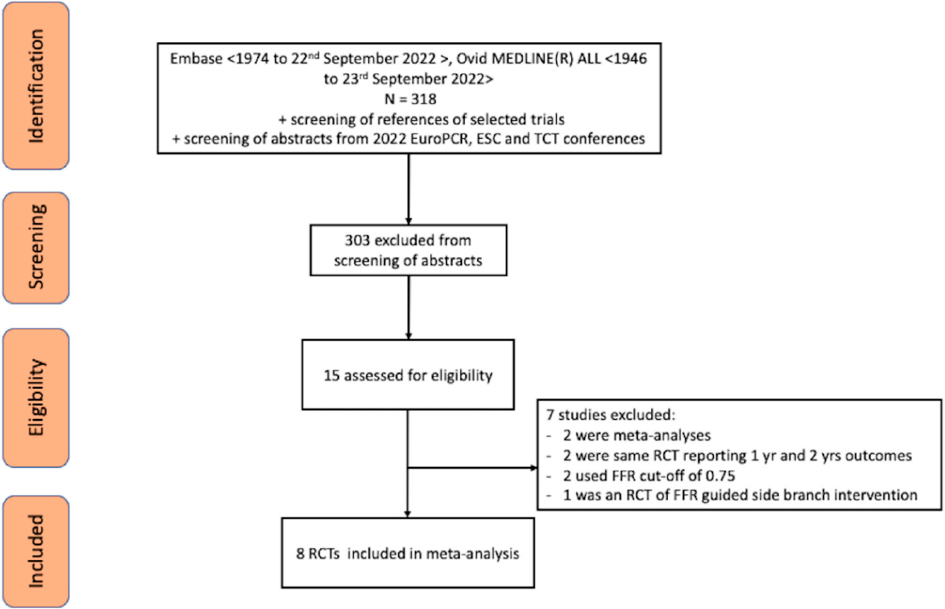
Figure 2. PRISMA diagram of the trial selection process.